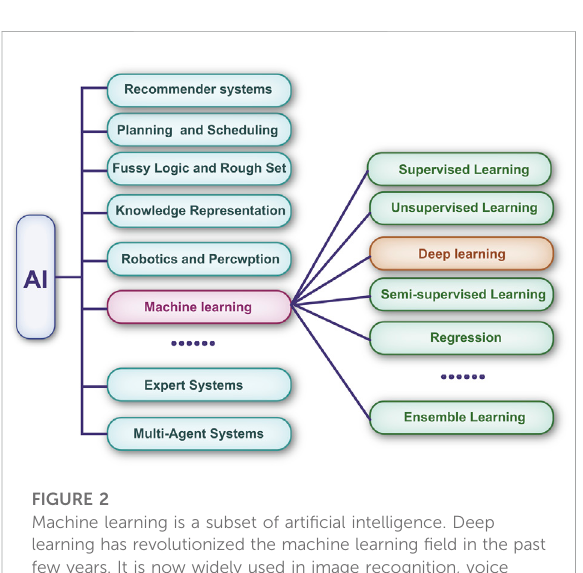
FIGURE 2 Machine learning is a subset of arti fi cial intelligence. Deep learning has revolutionized the machine learning fi eld in the past few years. It is now widely used in image recognition, voice recognition,